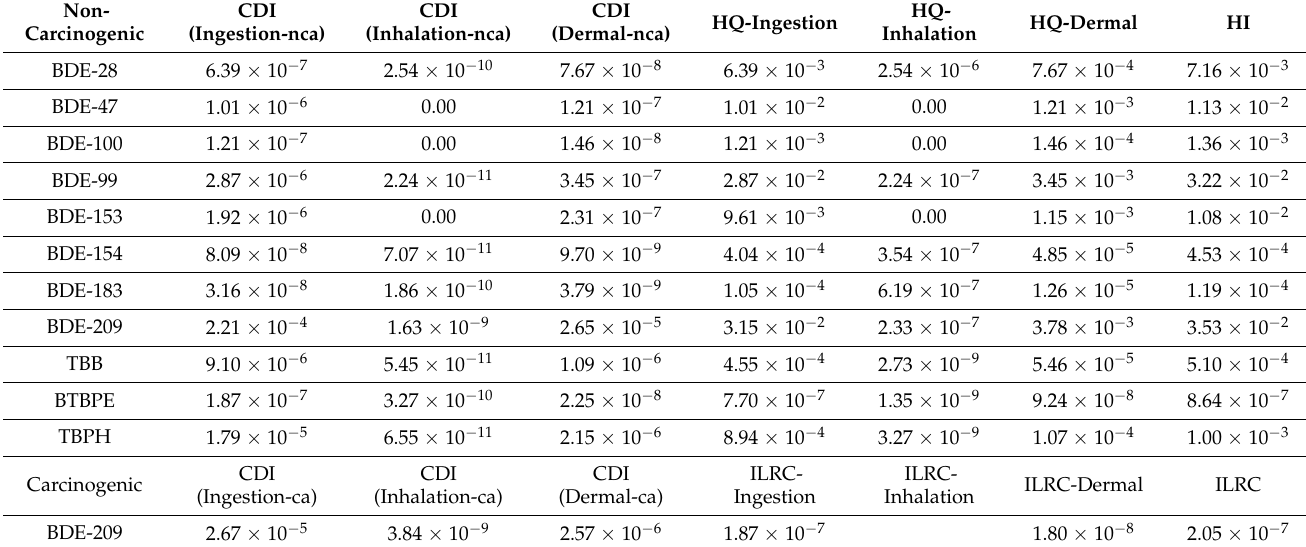
Table 2. Calculated potential cancer (ILCR) and non-carcinogenic (HQ and HI) risk assessment for Saudi children using 90th percentile values of BFRs in floor dust collected from their rooms. Non-